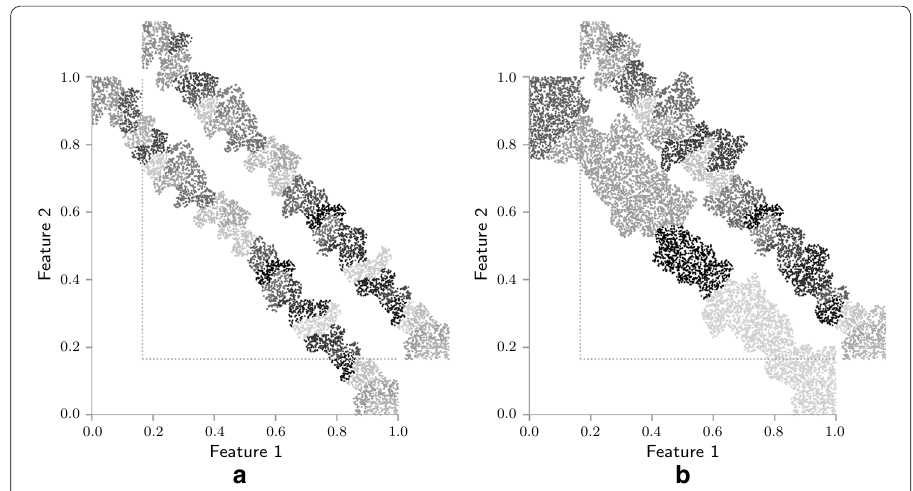
Fig. 8 Partitioning of training set. Number of coarsening iterations is 2 and 10 for ( a ) and ( b ), respectively. In each subfigure, the first plot is for the re-assessment case I, whereas the overlaying plot with shifted origin is for case II